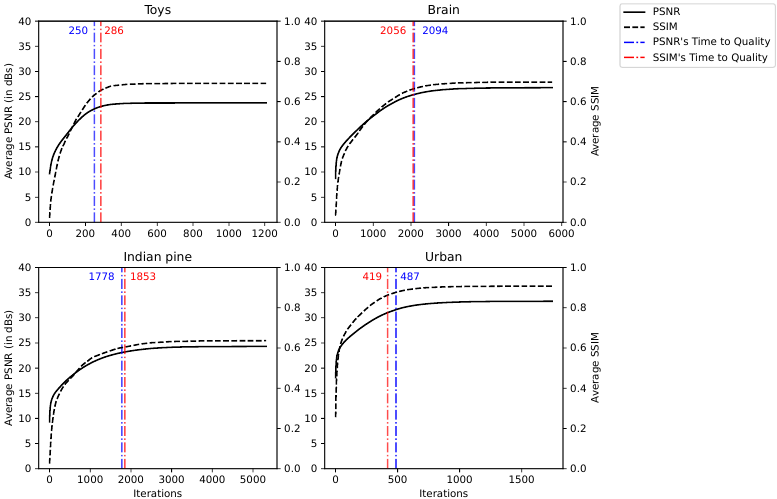
Figure 6. PSNR and SSIM for reconstructions of the CGNE over various